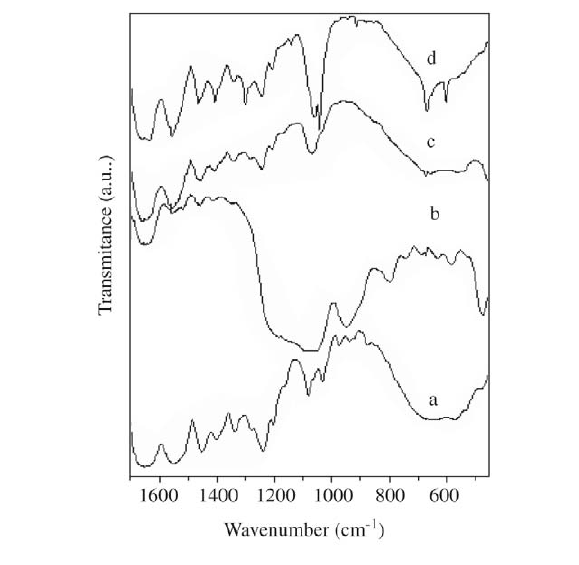
Figure 4. FTIR spectra of collagen samples: a) before any chemi- cal treatment, b) after TEOS treatment, c) immersed for 5 days in SBF solution, d) chemically treated and immersed in SBF solu- tion for 5 days.